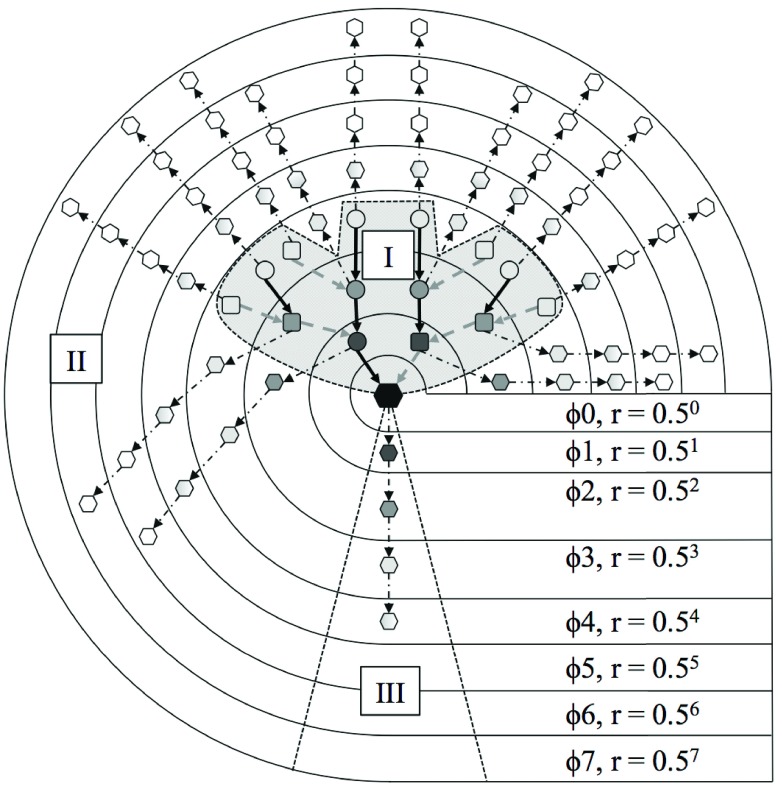
The use of SIGs in model testing.A 3-degree ascendant, 4-degree descendent SIG is shown with ascendant (I), descendant (III) and lateral (II) kin path sets identified as described in
Figure 1. SIGs were constructed for all focal individuals (represented by the black node) who have a complete set of documented third-degree ascendant relatives (I), in which all their known relatives are represented. For each focal individual, the numbers of local and global kin (local kin and global kin variables in
Table 1) in each ascendant (I) and lateral (II) kin class were counted each month. We estimated how well the reproductive success of focal
 individuals (descendent relatives in path set III) was predicted by cohabitation of kin classes in path sets I and II. ϕ = degree of relatedness.